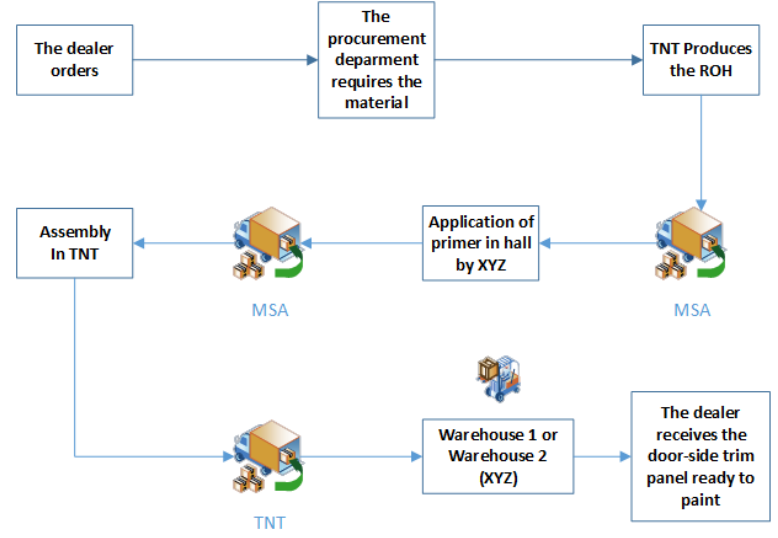
Figure 17. First proposal for improvement.